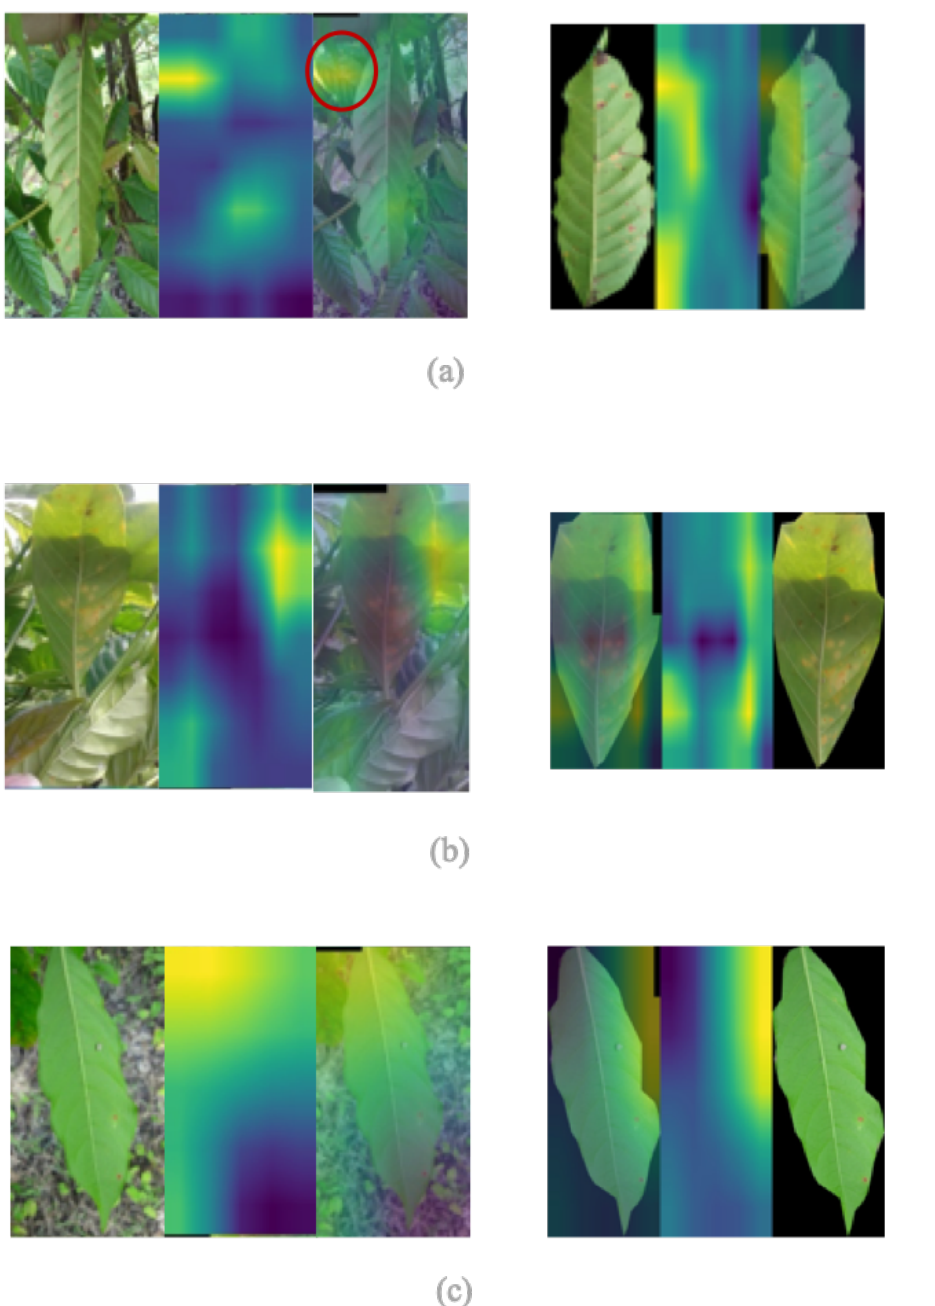
Figure 9. Representative examples of the correct classifications without preprocessing (left) and relative misclassifications with preprocessing (right). ( a ) is an example in which the classifier used parts of the background for the final decision. ( b ) shows the neural activations of the model un- der suboptimal lighting conditions. ( c ) highlights the behavior of the network in the presence of small